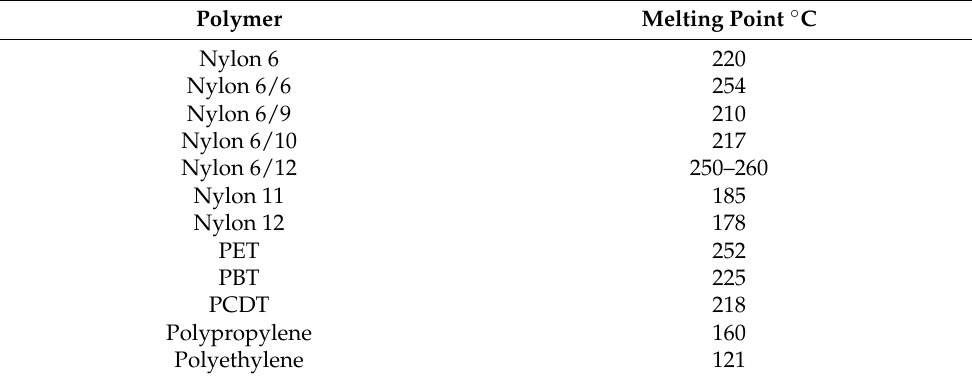
Table 1. Manufacturer provided melting points of the various polymer standards used in this study (Scientific Polymer Products, Inc., Ontario, NY,